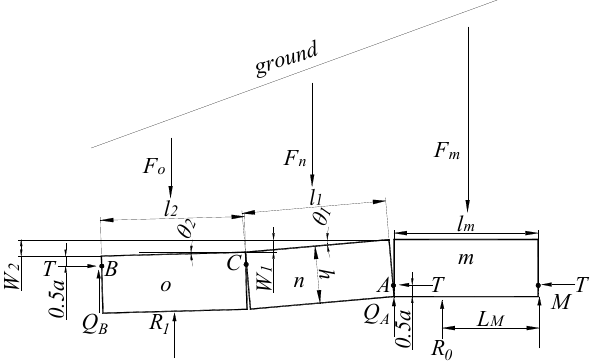
Appl. Sci. 2020 , 10 , x FOR PEER REVIEW Figure 6. Structural mechanical model of rock block during first caving of the main roof.